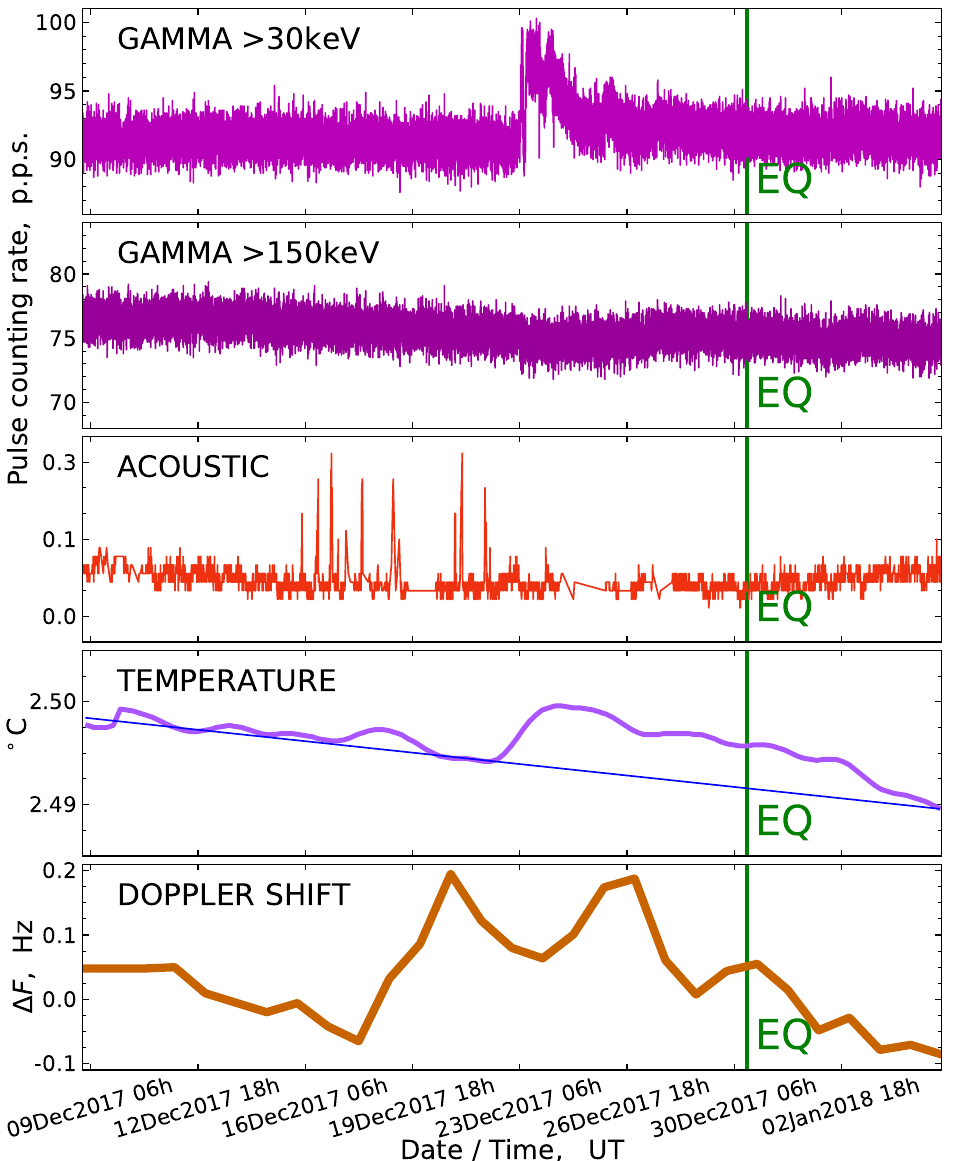
Figure 5. The records of signal intensity at the detectors of the Tien Shan station, which were written in the period preceding the 30 December 2017 earthquake. From top to bottom : the counting rate, in pulses per second, of the gamma ray signals detected in the E γ (cid:62) 30 keV and E γ (cid:62) 150 keV channels of the underground detector, and of the high amplitude acoustic pulses; the temperature, in centigrade, measured at the depth of 40 m; and the Doppler shift values. The moment of the earthquake (EQ) in each plot is marked by the thick vertical